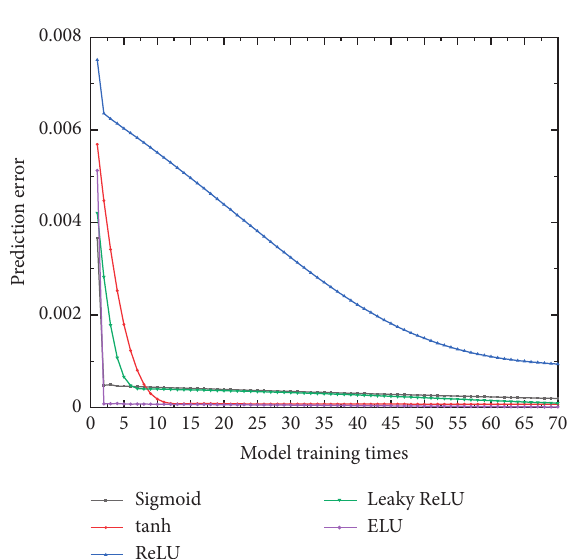
Figure 9: Loss value changes during the training process using the first set of bearing